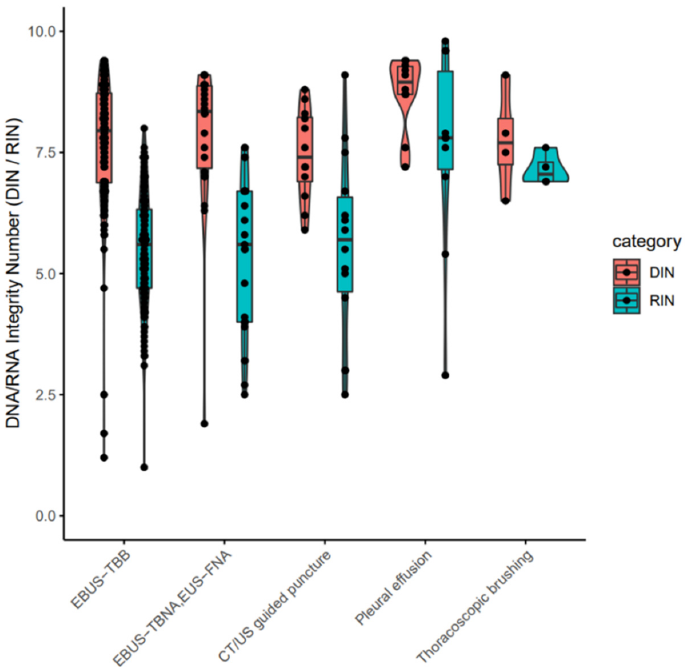
Figure 4. DIN/RIN values for purified nucleotides from cytology samples. EBUS-TBB: Endobron-